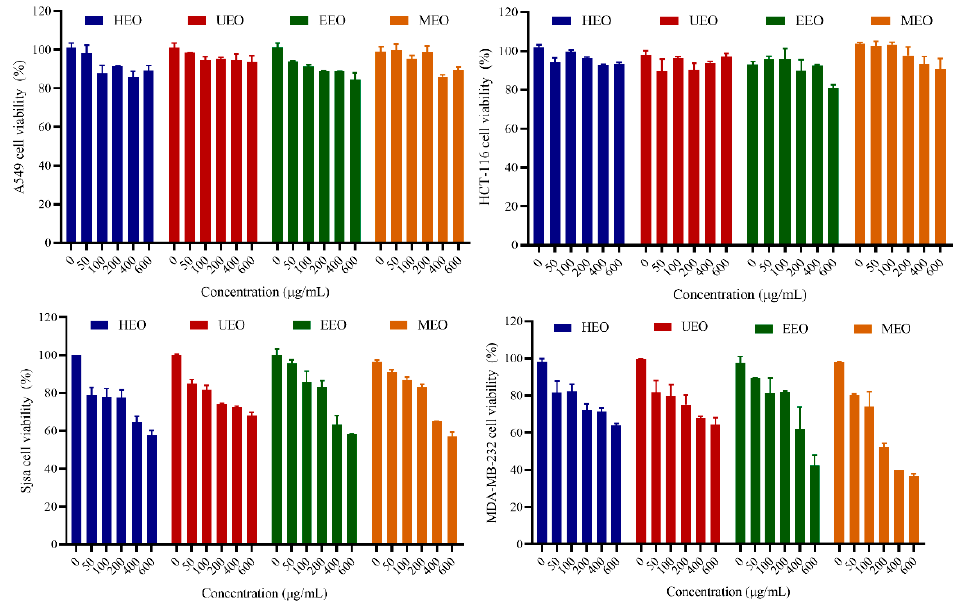
Figure 8. Proliferation activity of EOs on cancer cell lines.